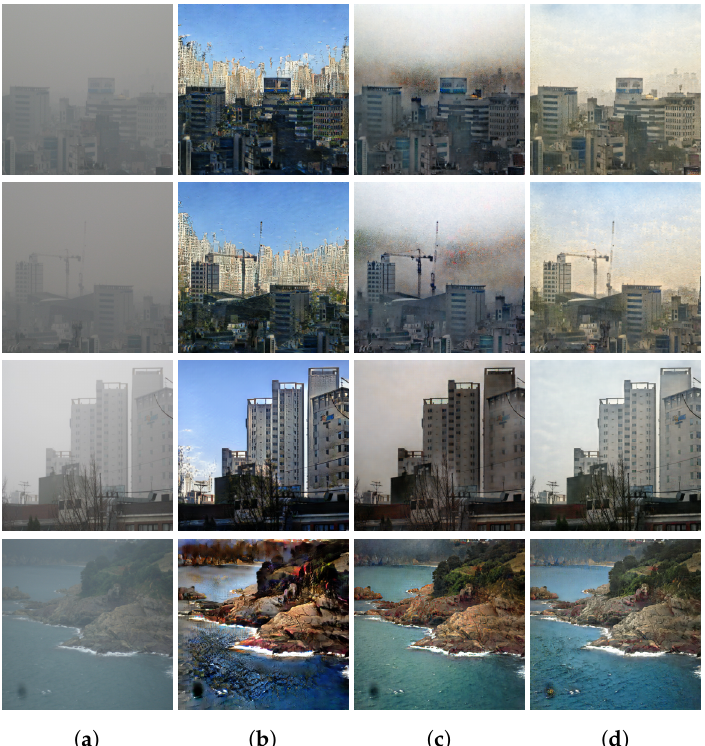
Figure 8. Qualitative comparison of defogging on real images with severe fog. ( a ) Foggy images, ( b ) unpaired approach [7] (note the heavy insertion of artifacts), ( c ) paired approach [34], ( d ) CurL- Defog. Images are better viewed if enlarged on a computer